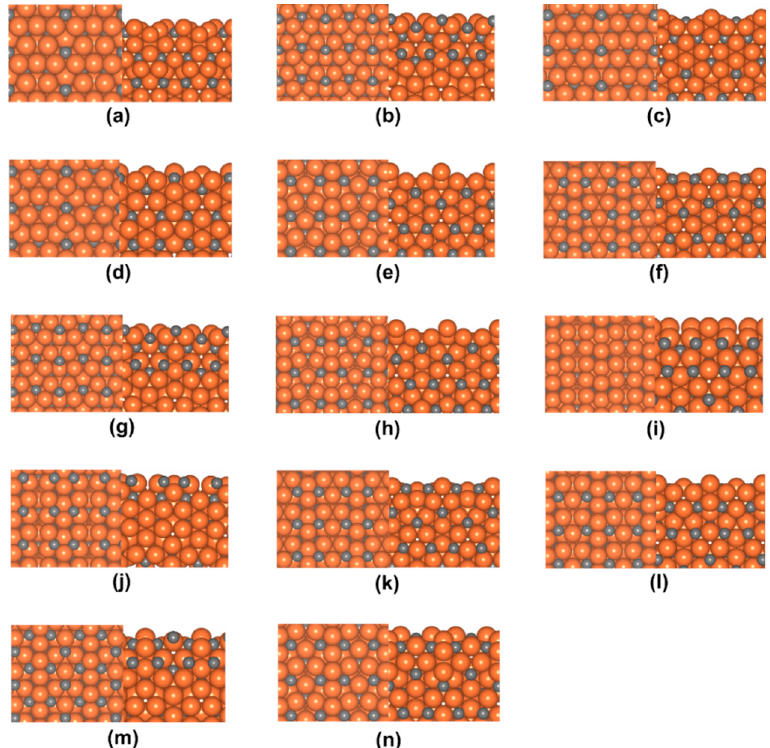
Figure 2. Top and side views of o-Fe 7 C 3 (001) surfaces with various terminations: ( a ) (001) 0.06 , ( b ) (001) 0.09 , ( c ) (001) 0.13 , ( d ) (001) 0.15 , ( e ) (001) 0.20 , ( f ) (001) 0.41 , ( g ) (001) 0.59 , ( h ) (001) 0.81 , ( i ) (001) 0.85 , ( j ) (001) 0.87 , ( k ) (001) 0.91 , ( l ) (001) 0.94 , ( m ) (001) 0.99 , and ( n ) (001) 1.00 . Orange and gray balls in the figure represent Fe and C, respectively.